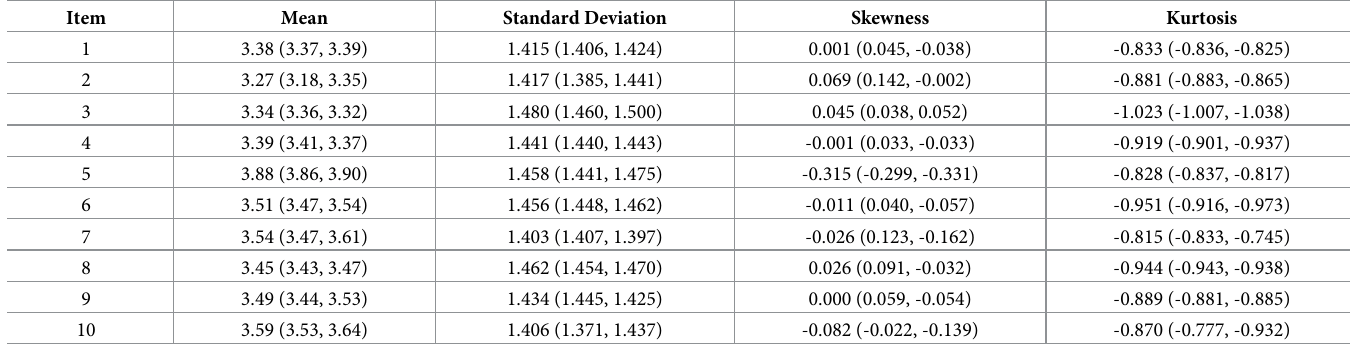
Table 1. Descriptive statistics of the SAS-SV [total (male, female)].